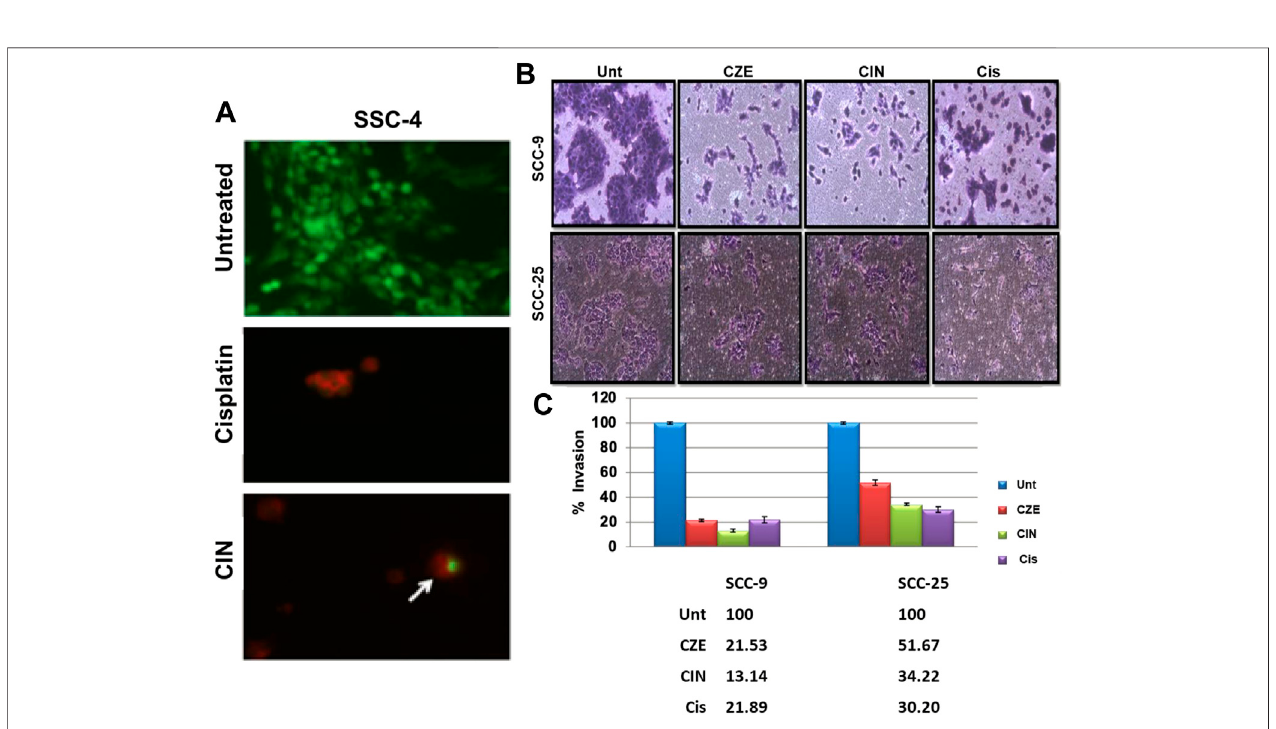
FIGURE 7| (A) Acridine orange staining showing acidic vesicular organelles (AVOs) in Cinnamaldehyde treated SCC4 cells. Arrows indicate the presence of bright red fl uorescing autophagic vacuoles in the cell cytoplasm. No such vacuoles can be seen in the untreated SCC-4 cells (B) Matrigel assay showing decreased invasiveness of SCC-9 and SCC-25 cells post CZE and CIN treatment. Representative pictures of crystal violet stained untreated, CZE, CIN and cisplatin treated oral cancer cells (SCC-9, SCC-25) at 48 h. The experiment was performed in duplicates and three fi elds were counted for each chamber (C) Bar graphs showing a dose-dependent decrease in percentage invasion (Mean ± SD) of extract treated and CIN treated cancer cells. CZE and CIN treatment inhibited the migration of OSCC cells.